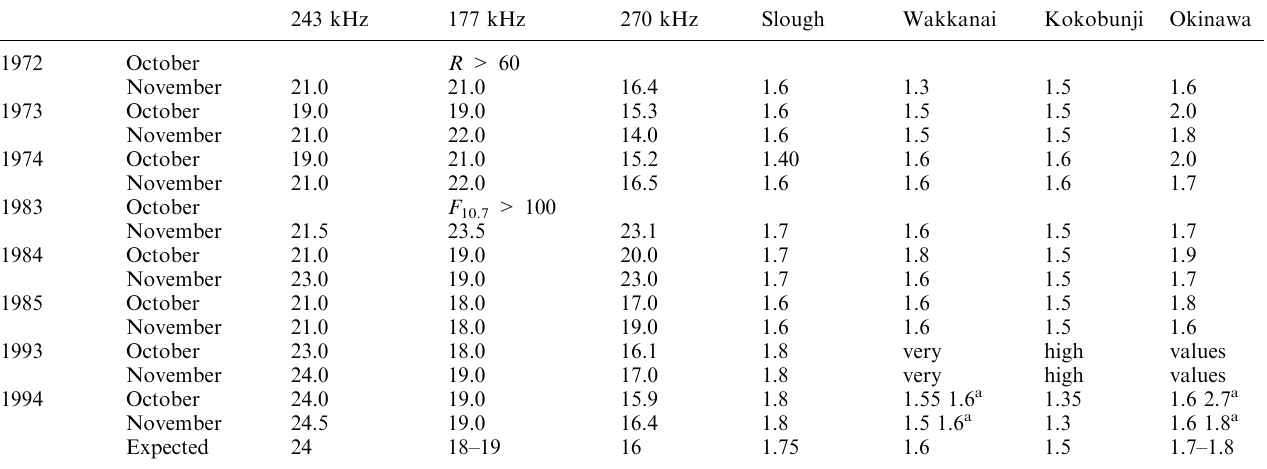
Table 3. Long-term development of the nighttime LF radio wave absorption in Central Europe at three frequencies and of f Europe (Slough) and Japan (Wakkanai, Kokobunji and Okinawa) under solar activity conditions similar to those of October–November 1994 243 kHz 177 kHz 270